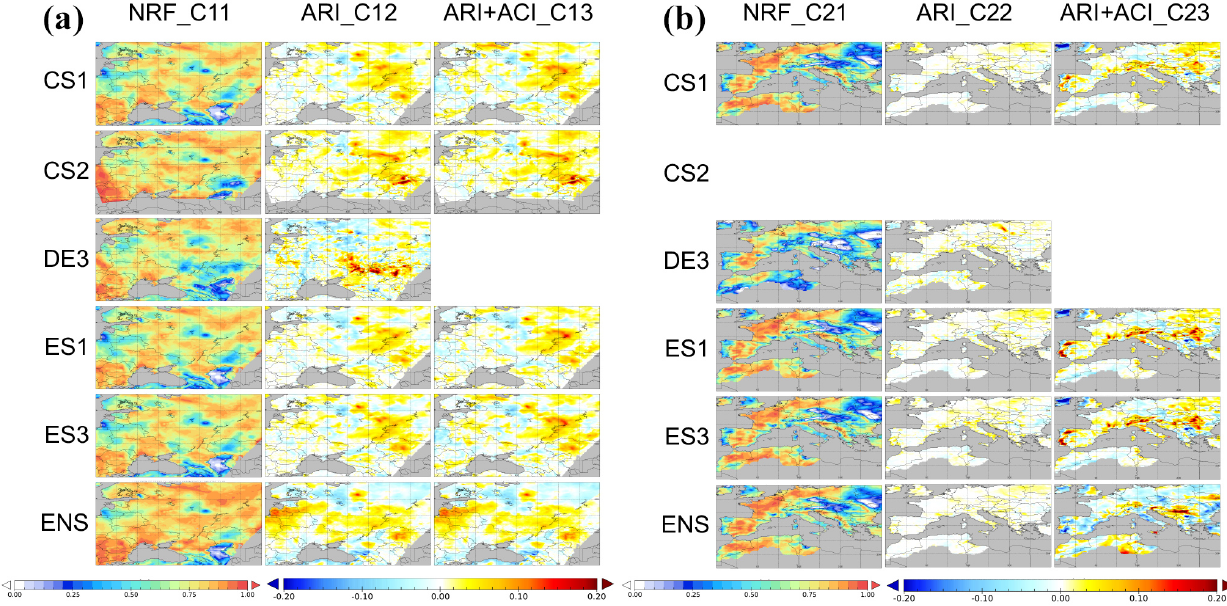
Figure 5. Time determination coefficient ( ρ 2 ) (model vs. E-OBS) of the maximum temperature (TMAX) for the fire (a) and dust (b) episodes. The first column in each panel represents the value of ρ 2 of the no radiative feedback case with respect to the E-OBS database. The center and right columns indicate the increase (red values) or decrease (blue value) in each simulation with respect to the case not including feedbacks.